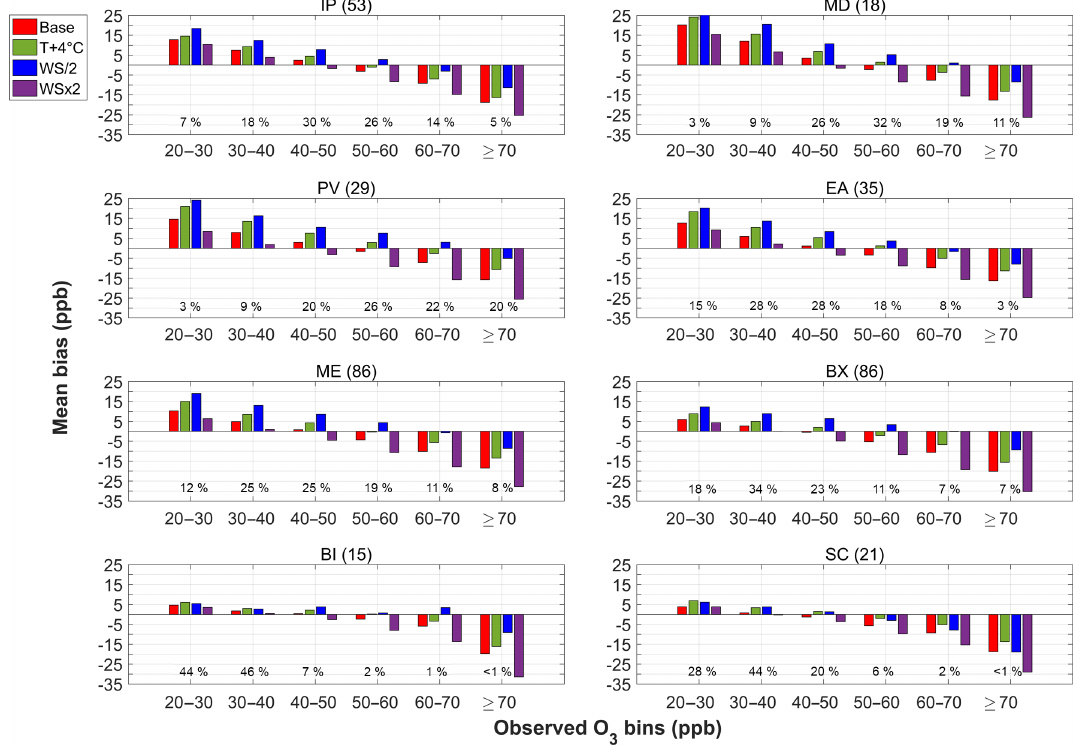
Figure 11. Mean bias of the afternoon (12:00–18:00UTC) surface O 3 mixing ratios for each bin of observed surface O 3 mixing ratios for various meteorological scenarios in eight European regions in summer 2010. Percentage values below the bars indicate the fraction of the values assigned to each bin for each region. The number of stations available for each region is reported in parentheses at the top of each panel. A definition of the regions is given in Fig.